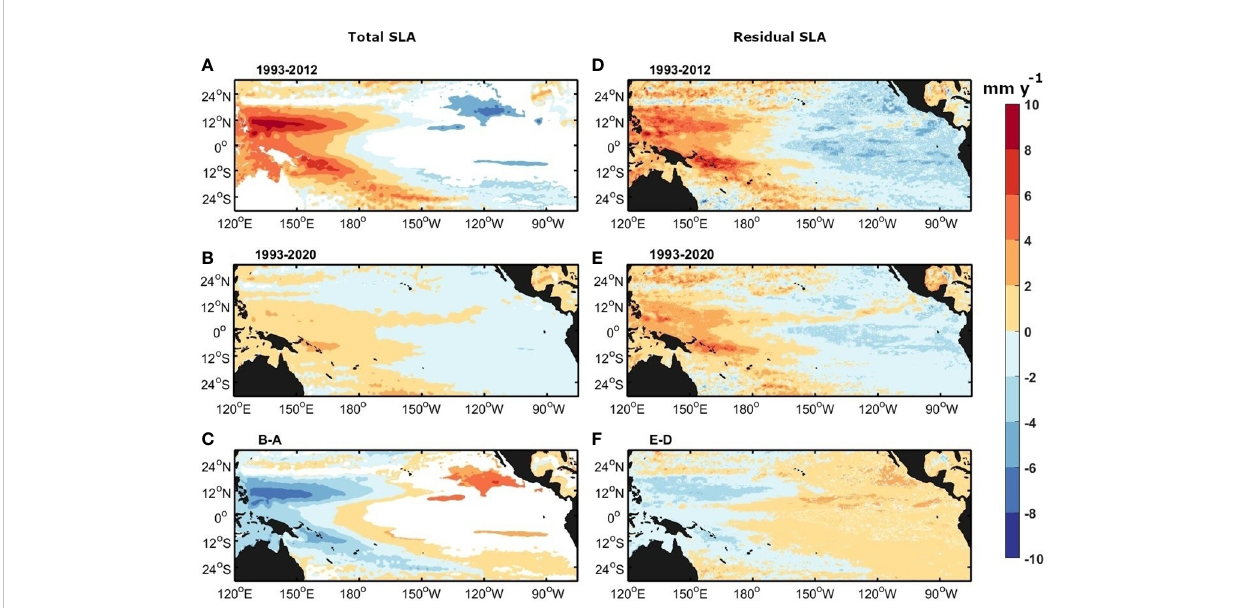
FIGURE 1 Spatial pattern of linear trend (mm year − 1 ) in altimeter measured SLA for the periods (A) 1993 – 2012 and (B) 1993 – 2020 after the removal of GMSL trend, and (C) is (B) – (A) . Similarly, (D) and (E) are like (A) and (B) ; however, trends are estimated using residual SLA and (F) is (E) – (D) . Only statistical signi fi cance values at 95% con fi dence level are shown using standard t